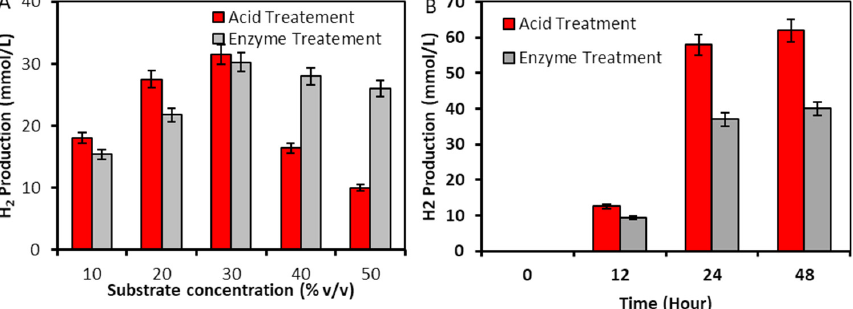
Figure 4. ( A ) Hydrogen production by E. cloacae DT-1 from di ff erent concentrations of acid-treated prehydrolysate and enzymatically saccharified duckweed biomass; ( B ) hydrogen production performance of E. cloacae DT-1 from optimum concentrations of acid-treated prehydrolysate and enzymatically saccharified hydrolysate of duckweed biomass, under decreased partial pressure.